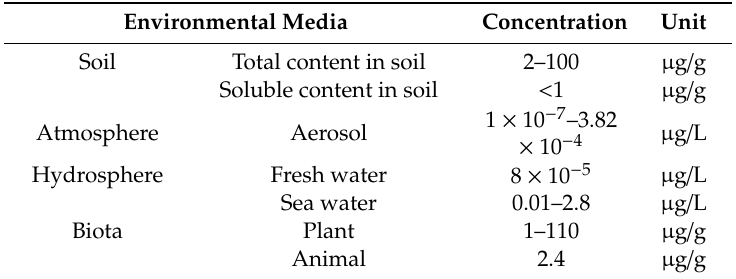
Table 1. Concentration of Copper in natural environmental media